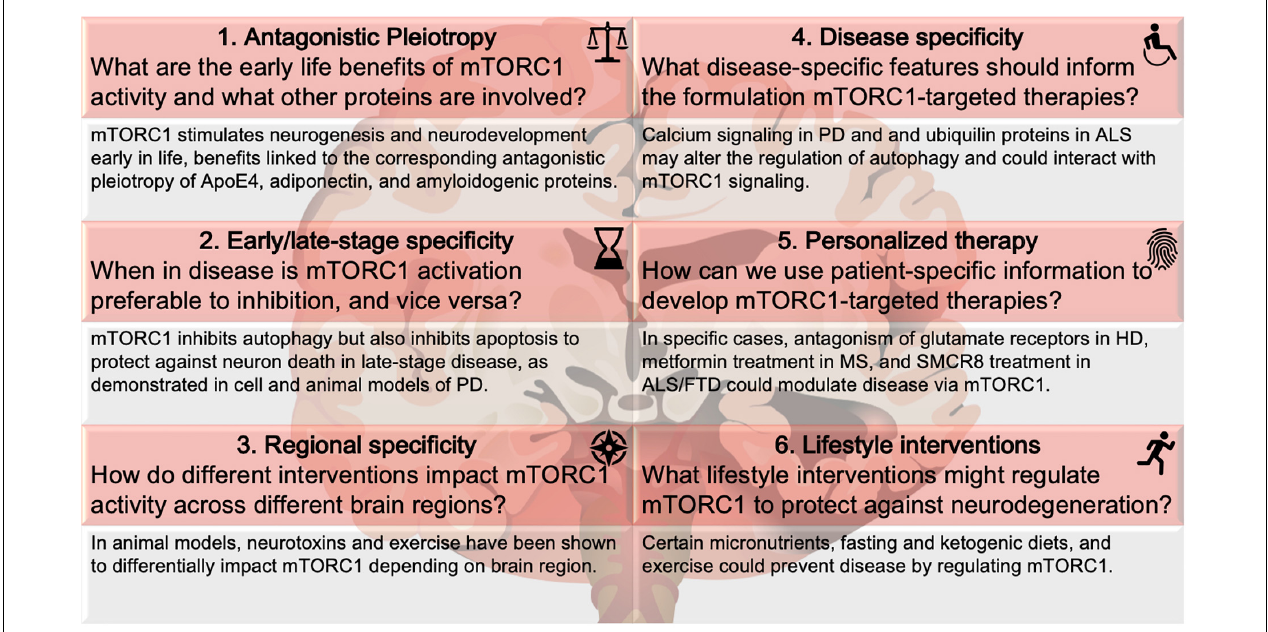
FIGURE 2 | mTORC1 mysteries. Six nuances regarding mTORC1 in neurodegenerative disease. The questions and examples below each topic are illustrative, not comprehensive, of the literature covered in this review. Disease abbreviations: ALS, Amyotrophic Lateral Sclerosis; FTD, frontotemporal dementia; HD, Huntington’s disease; MS, multiple sclerosis; PD, Parkinson’s